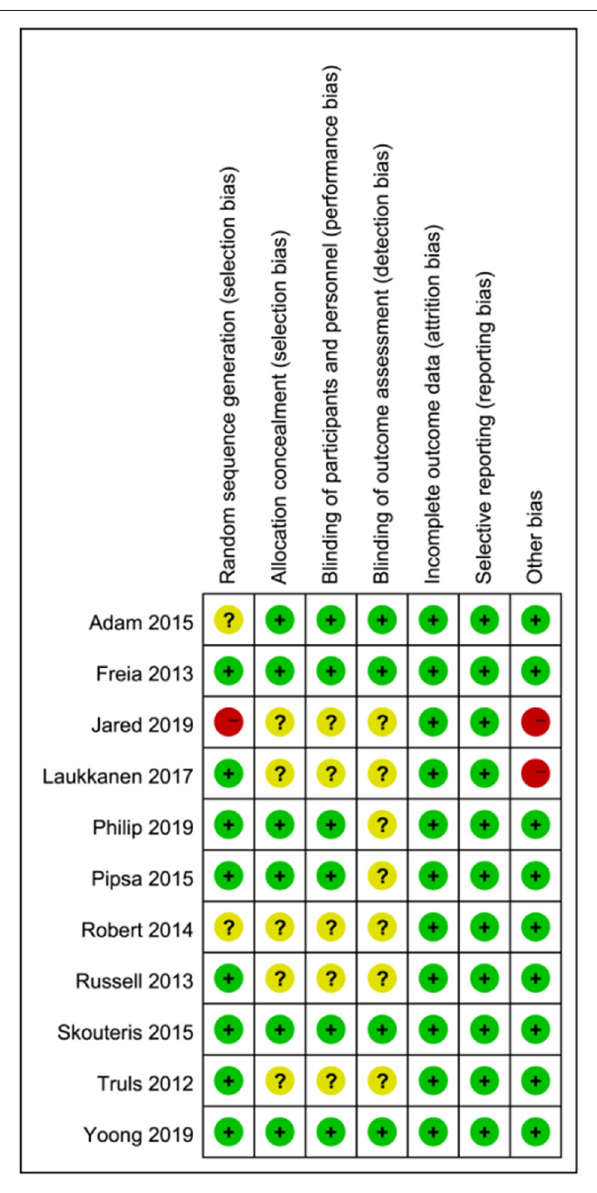
low risk of bias; yellow =